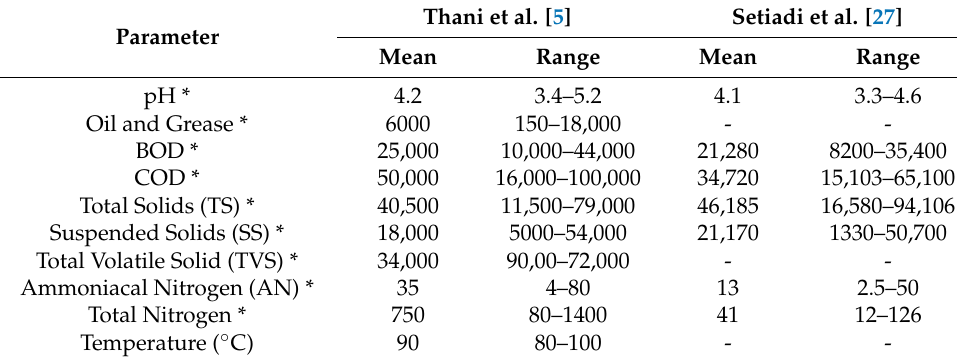
Table 1. Characteristics of POME.